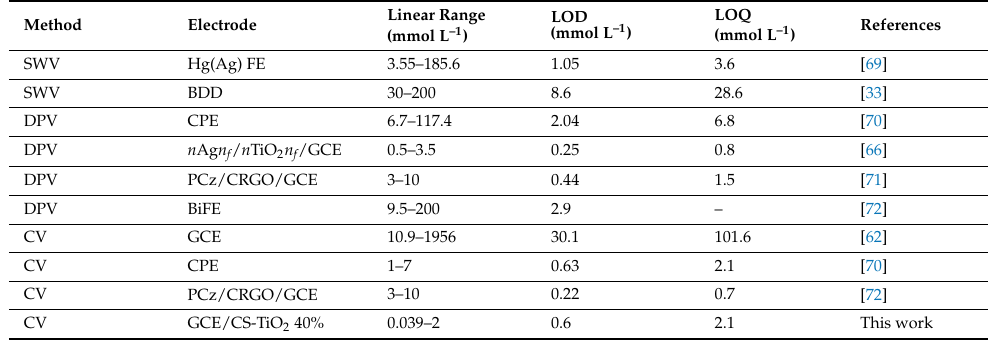
Table 2. Comparison of different electrodes in the detection of